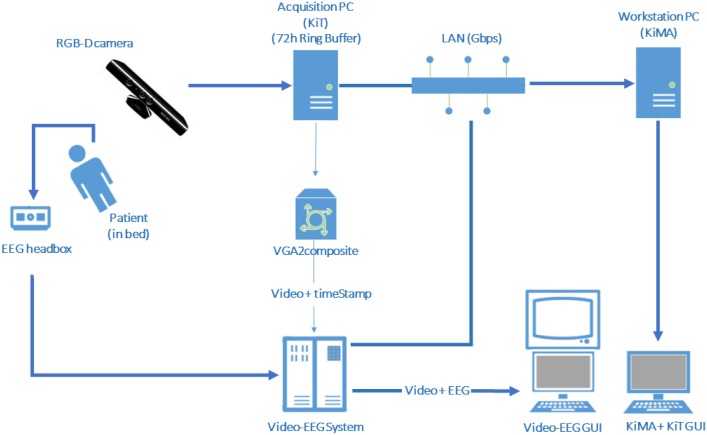
NeuroKinect architecture deployed inside the University of Munich EMU.